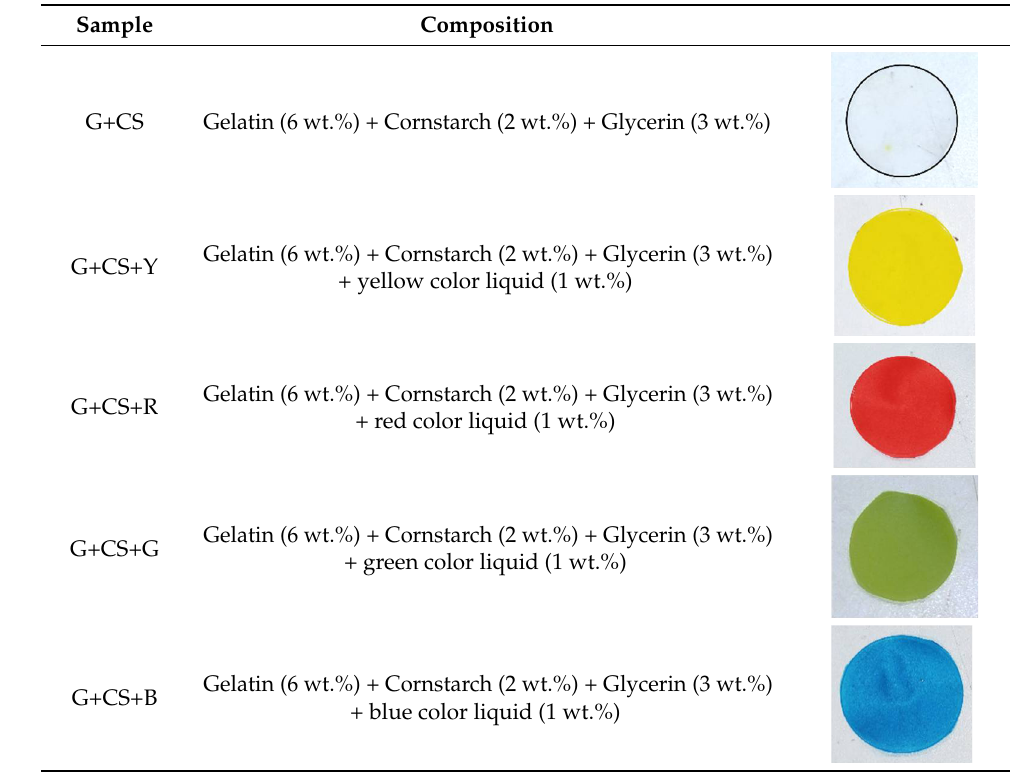
Table 1. Concentration of edible film with and without different food colors.